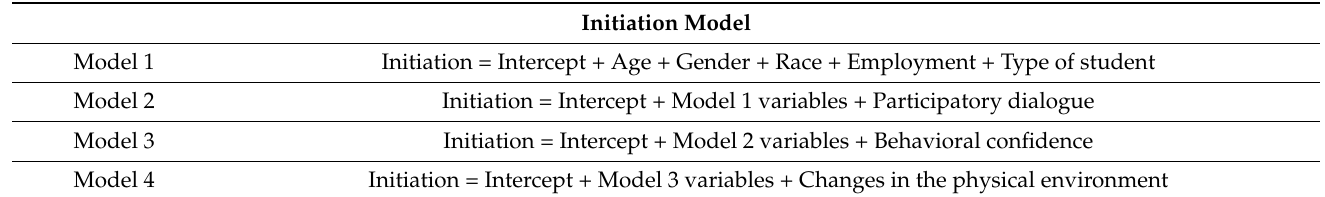
Table 1. Hierarchical multiple regression model building